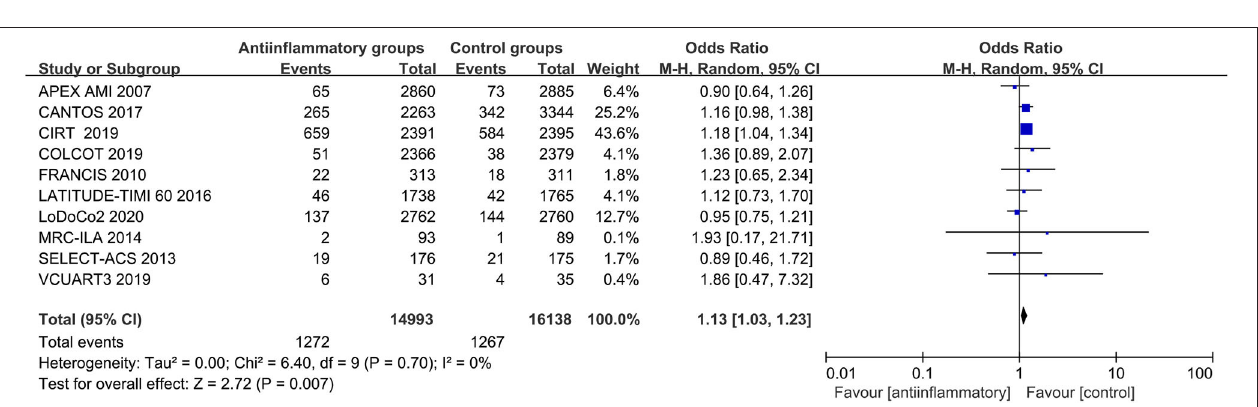
FIGURE 6 | Forest plots of studies evaluating primary end points in patients receiving colchicine vs. placebo.